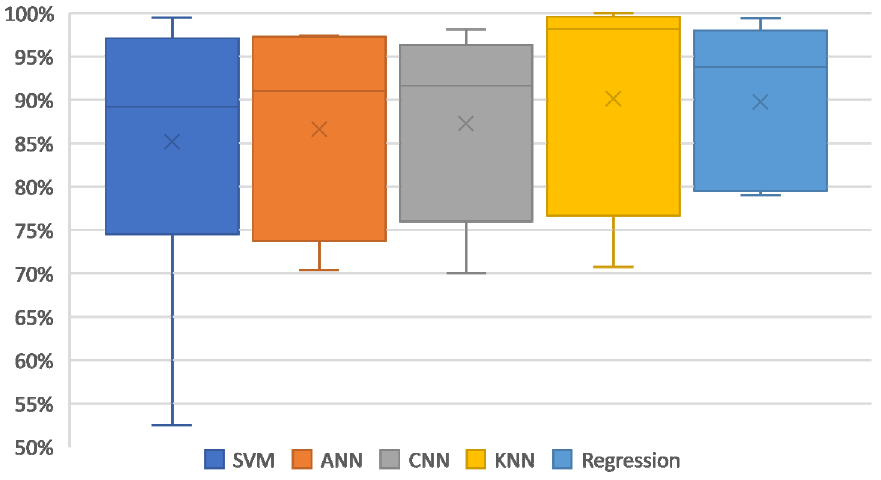
Figure 9. Box plot of occupancy counting algorithms usage accuracy.